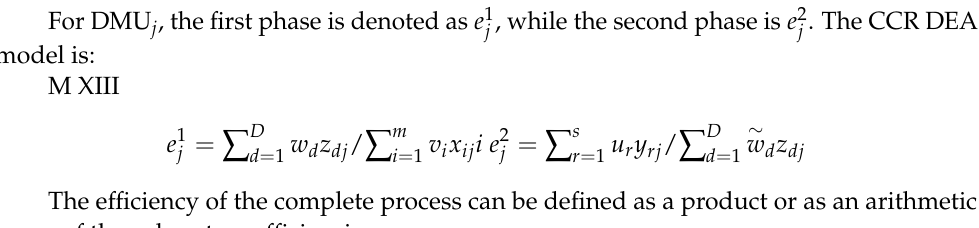
Figure 4. Two-stage process bargaining model with unlimited number of offers [37].